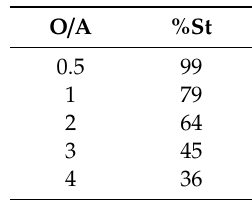
Temperature: 20 ◦ C. Equilibration time: 10 min.